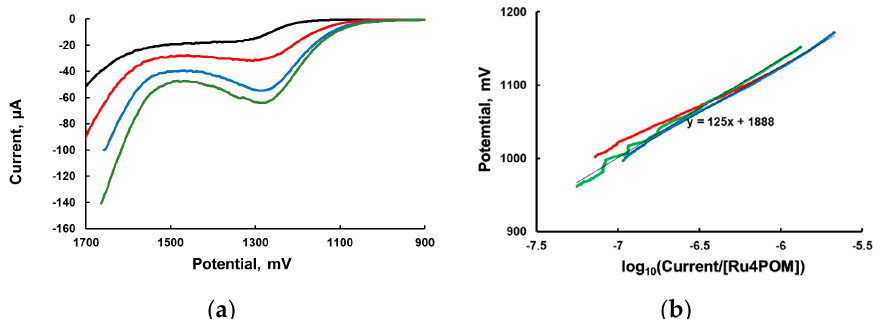
Figure 2. ( a ) Linear sweep voltammograms with stirring at a scan rate 3.0 mV/s of 1.0 mM [Ru(bpy) 3 ]Cl 2 in 80 mM sodium phosphate at pH 7.2. [ Ru 4 POM ]: 0 (black), 5 (red), 10 (blue), and 15 μ M (green and orange); ( b ) Tafel plot in the range of potentials between 900 and 1200 mV.